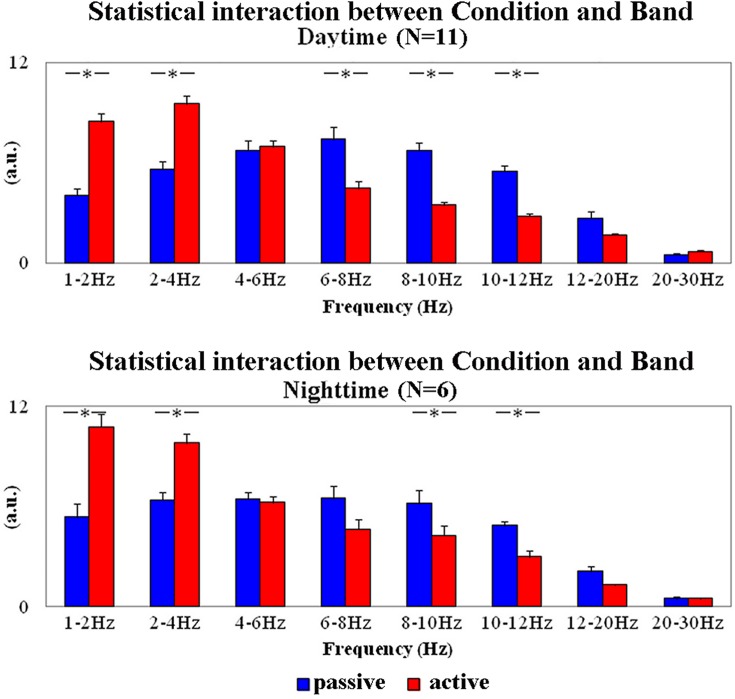
Mean values (± SE) of the normalized EEG power density in the active and passive states at the frequency bands of interest.These values refer to the daytime (N = 11) and nighttime (N = 6) periods of interest. Lemurs having an insufficient amount of artefact-free EEG epochs in the passive state for the final analysis were not considered (daytime: L#4 and L#10; nighttime: L#1, L#2, L#3, L#4, L#11, L#12, and L#13). In the figure, the illustrated values refer to the results of two ANOVAs. The first ANOVA showed a statistically significant interaction (F(7,70) = 34.556; p = 0.0001) between the factors Condition (active and passive states; independent variable) and Band (1–2 Hz, 2–4 Hz, 4–6 Hz, 6–8 Hz, 8–10 Hz, 10–12 Hz, 12–20 Hz, and 20–30 Hz) in the daytime. The second ANOVA showed a statistically significant interaction (F(7,35) = 16.103; p = 0.00001) between the same factors in the nighttime. Asterisks indicate the statistically significant differences (Duncan’s post hoc test; p<0.05).